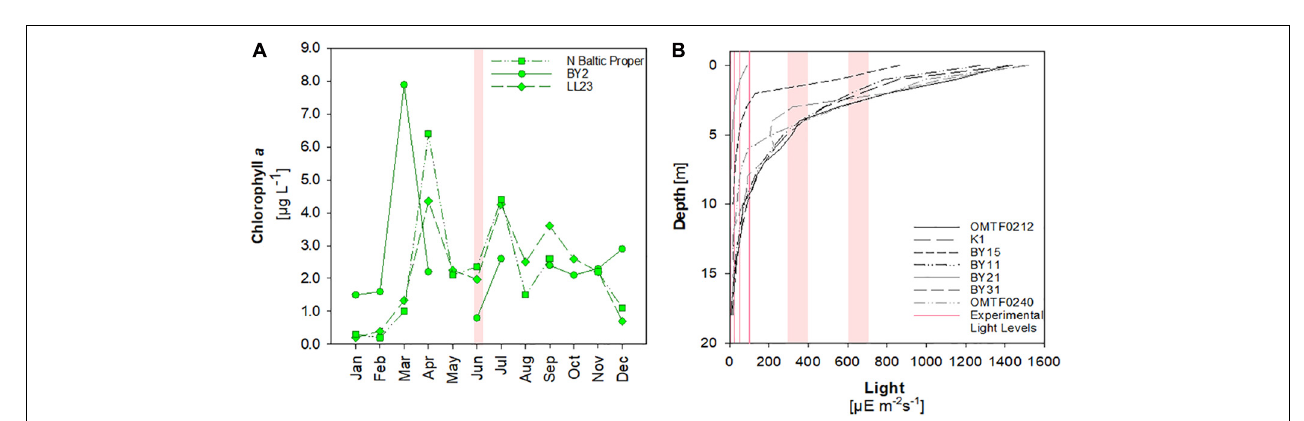
FIGURE 2 | (A) Seasonal development of chlorophyll a concentrations at selected HELCOM stations. The red shaded area indicates the time of sampling during June, 2015 (BY2: 55 ◦ N,14.1 ◦ E; LL23: 58.6 ◦ N, 18.2 ◦ E; N Baltic Proper: 58.8 ◦ N,20.5 ◦ E) (Data are retrieved from ICES Dataset on Ocean Hydrography. The International Council for the Exploration of the Sea, Copenhagen.). (B) Light profiles recorded during this study in June 2015 and experimental light